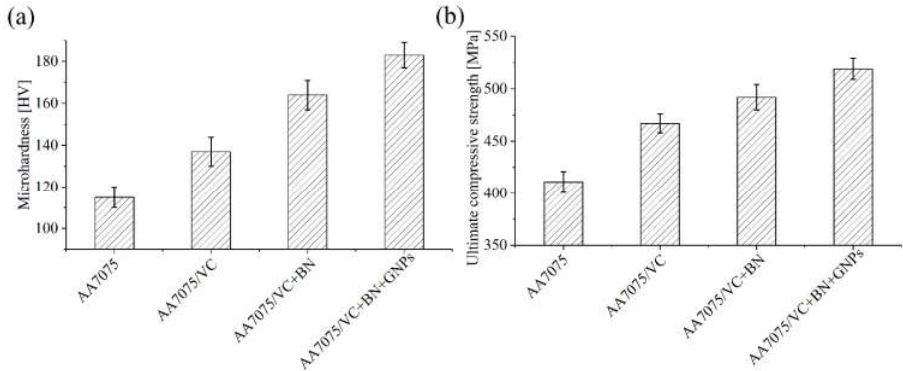
Figure 5. Mechanical properties of the manufactured composites. (a) Microhardness and (b) ulti- mate compressive